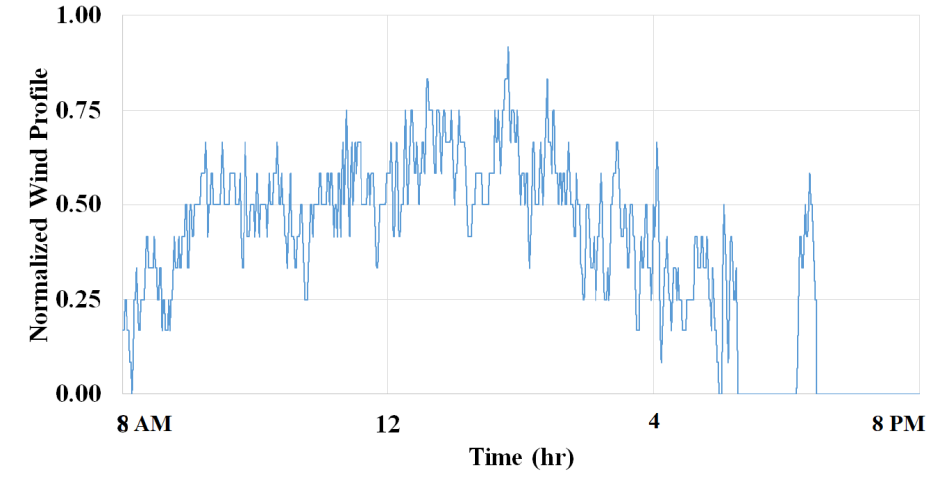
Figure 7. Intermittent wind power generation profile.